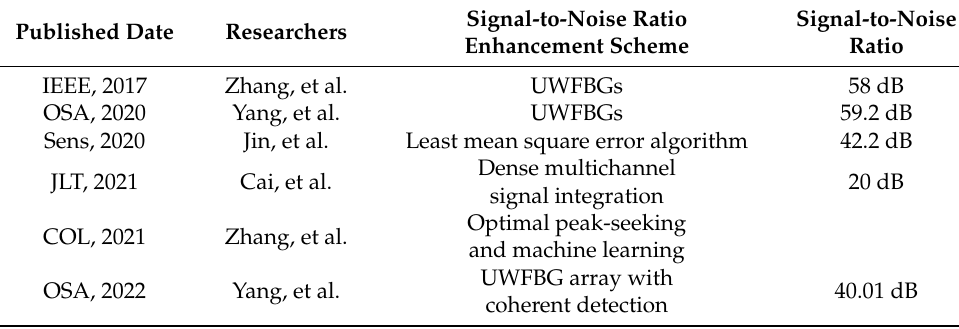
Figure 15. ( a ) Experimental setup. ( b ) Raw beat frequency signal [64]. Table 5. Research progress on SNR